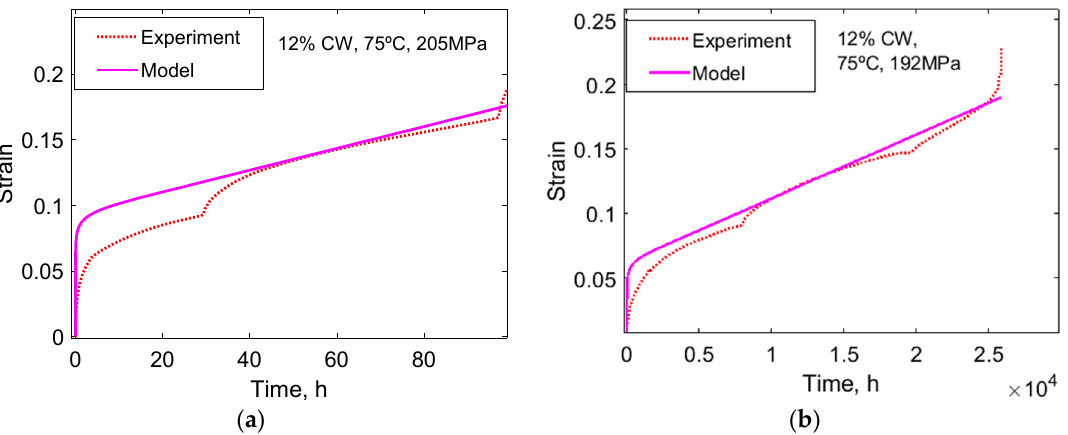
Figure 10. Creep strain versus time for 12% cold-work Cu-OFP at 75 °C ( a ) 205 MPa and ( b ) 192 MPa. Model results from integration of Equation (11). Redrawn with permission from ref. [16]. Copyright 2022 Elsevier.